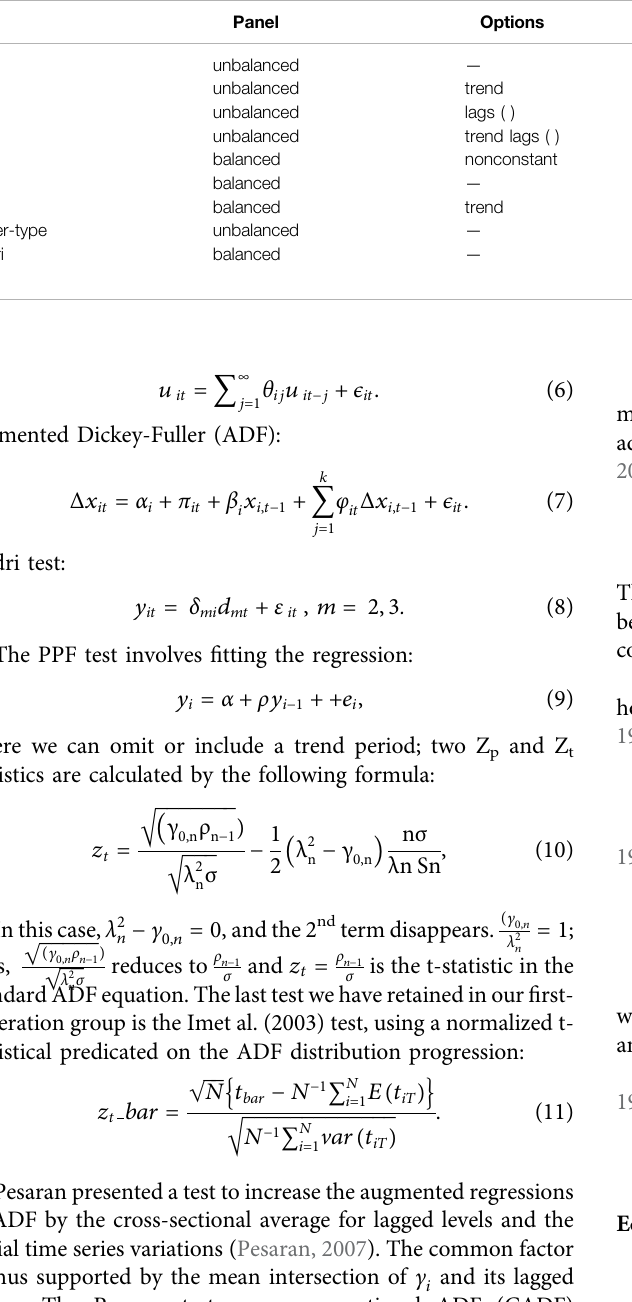
TABLE 1 | First-generation unit root test speci fi